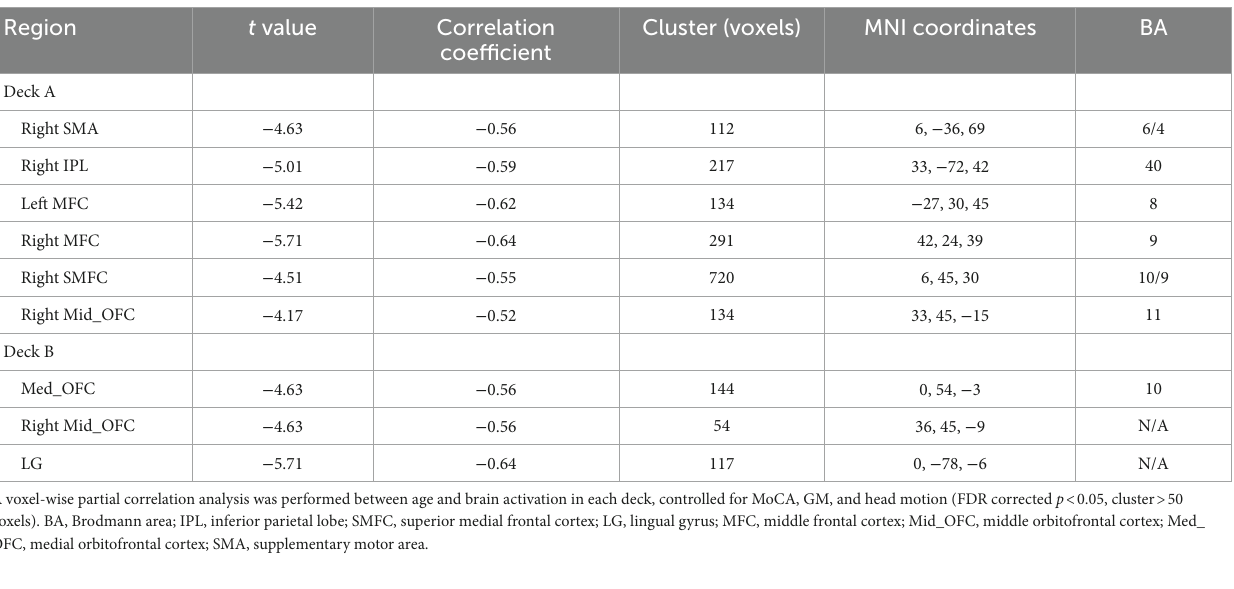
TABLE 4 Age-effect on brain activations during the IGT. Region t value Correlation